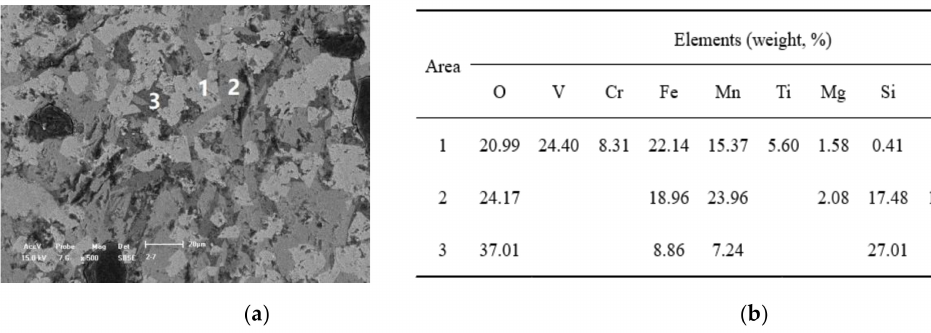
Figure 1. Scanning electron microscope and energy dispersive spectrometer (SEM-EDS) analysis for the converter vanadium slag ( a ) the scanning electron micrograph of the converter vanadium slag; ( b ) the energy dispersive spectrum analysis for different areas in Figure